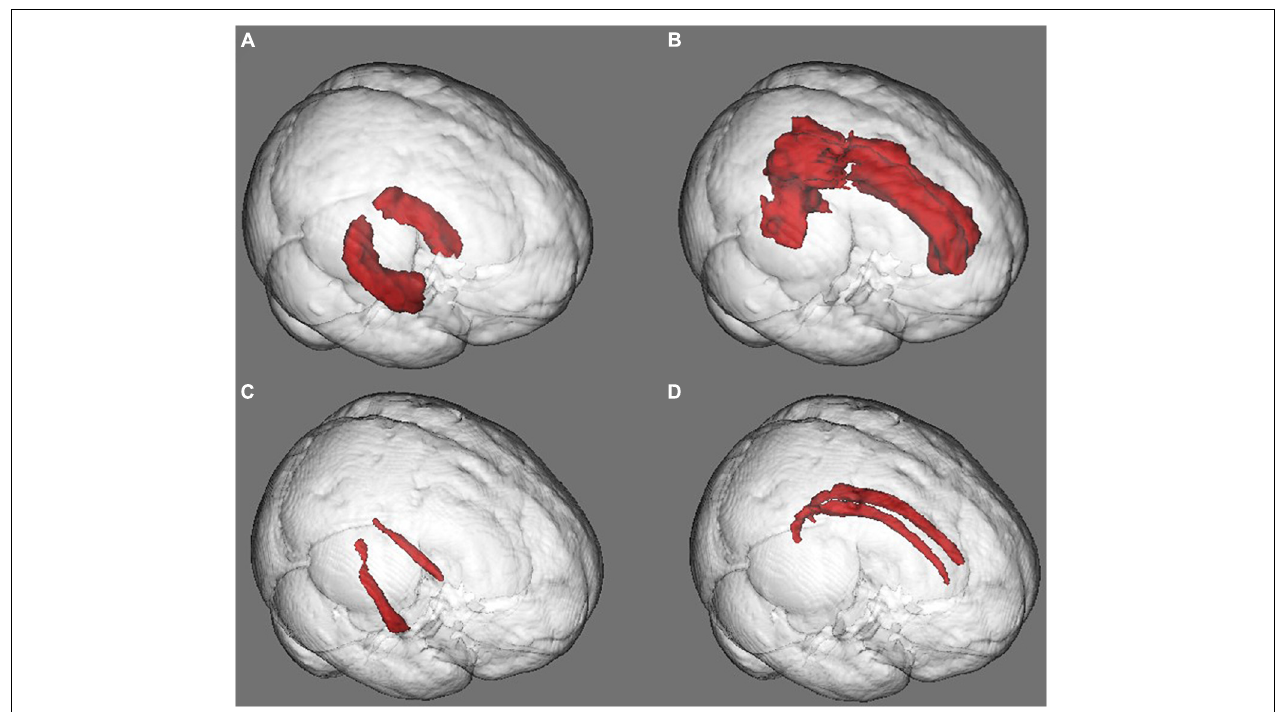
FIGURE 1 | Gray and white matter regions of interest (ROIs). (A) Hippocampal gray matter ROI. (B) Cingulum gray matter ROI. (C) Hippocampal white matter ROI. (D) Cingulum white matter ROI. The morphological or diffusion values were averaged in each ROI for between-group comparisons.